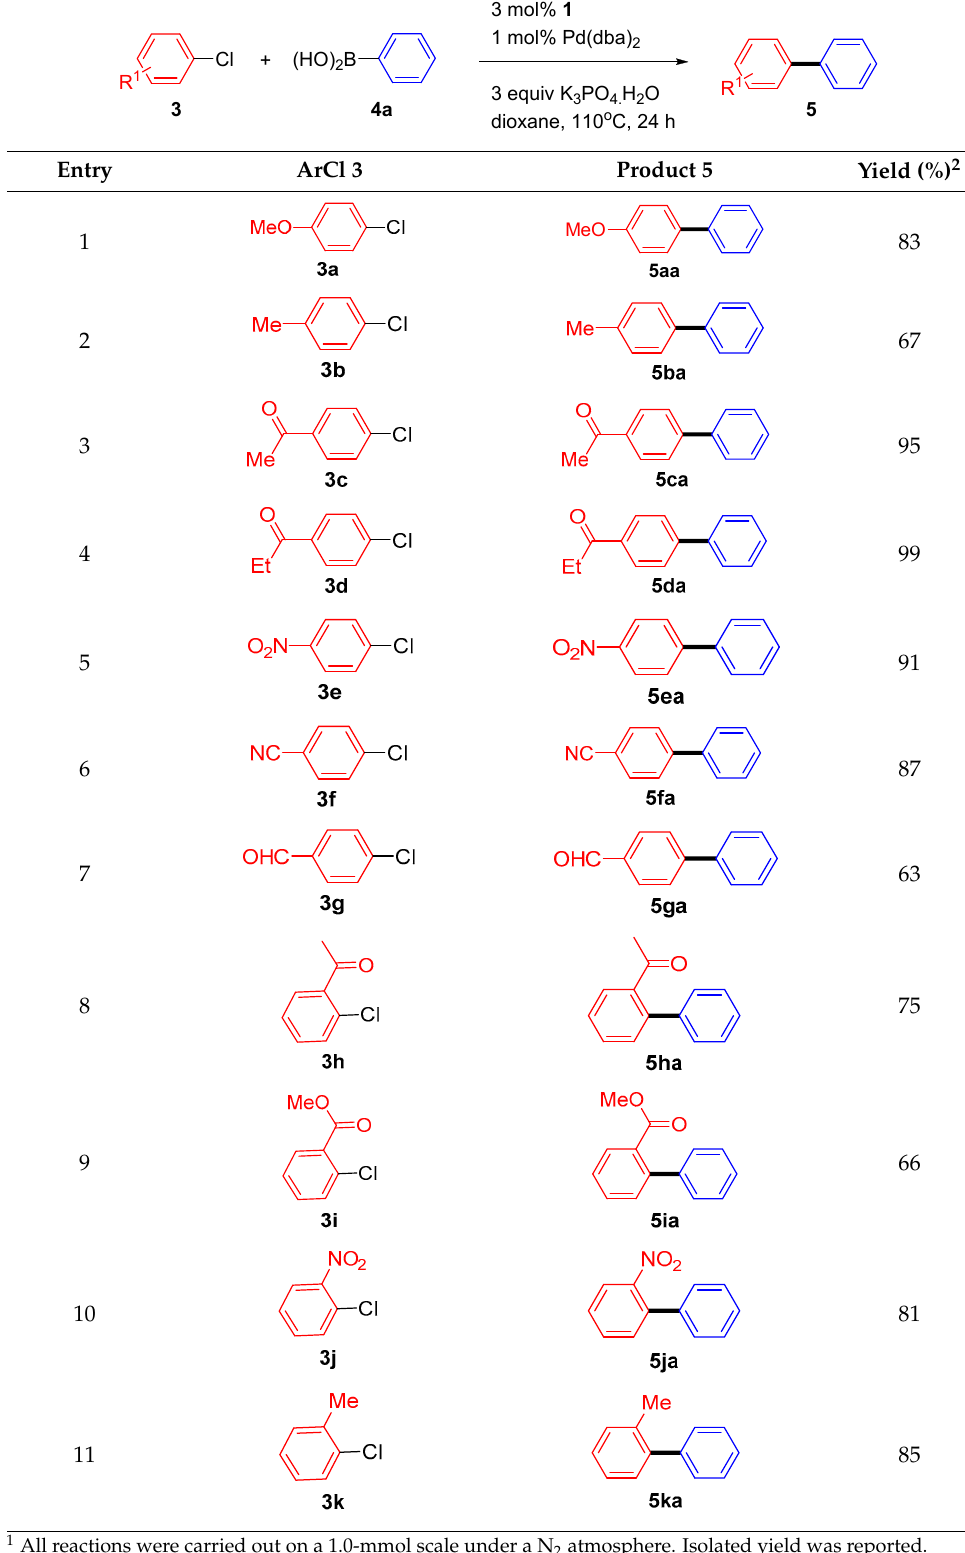
1 Table 2. In situ-generated catalyst catalyzed Suzuki–Miyaura cross-coupling reaction of aryl chlorides. 1